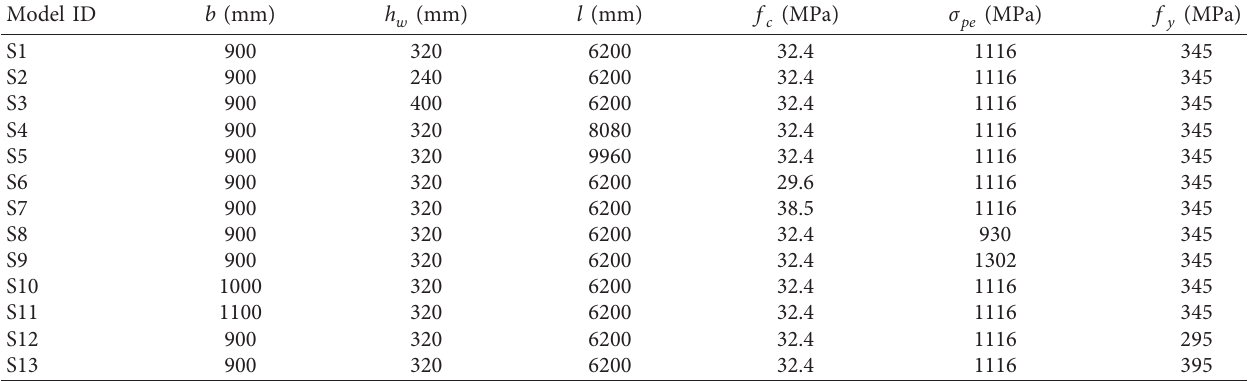
Table 2: Details of FE models in parametric analysis.